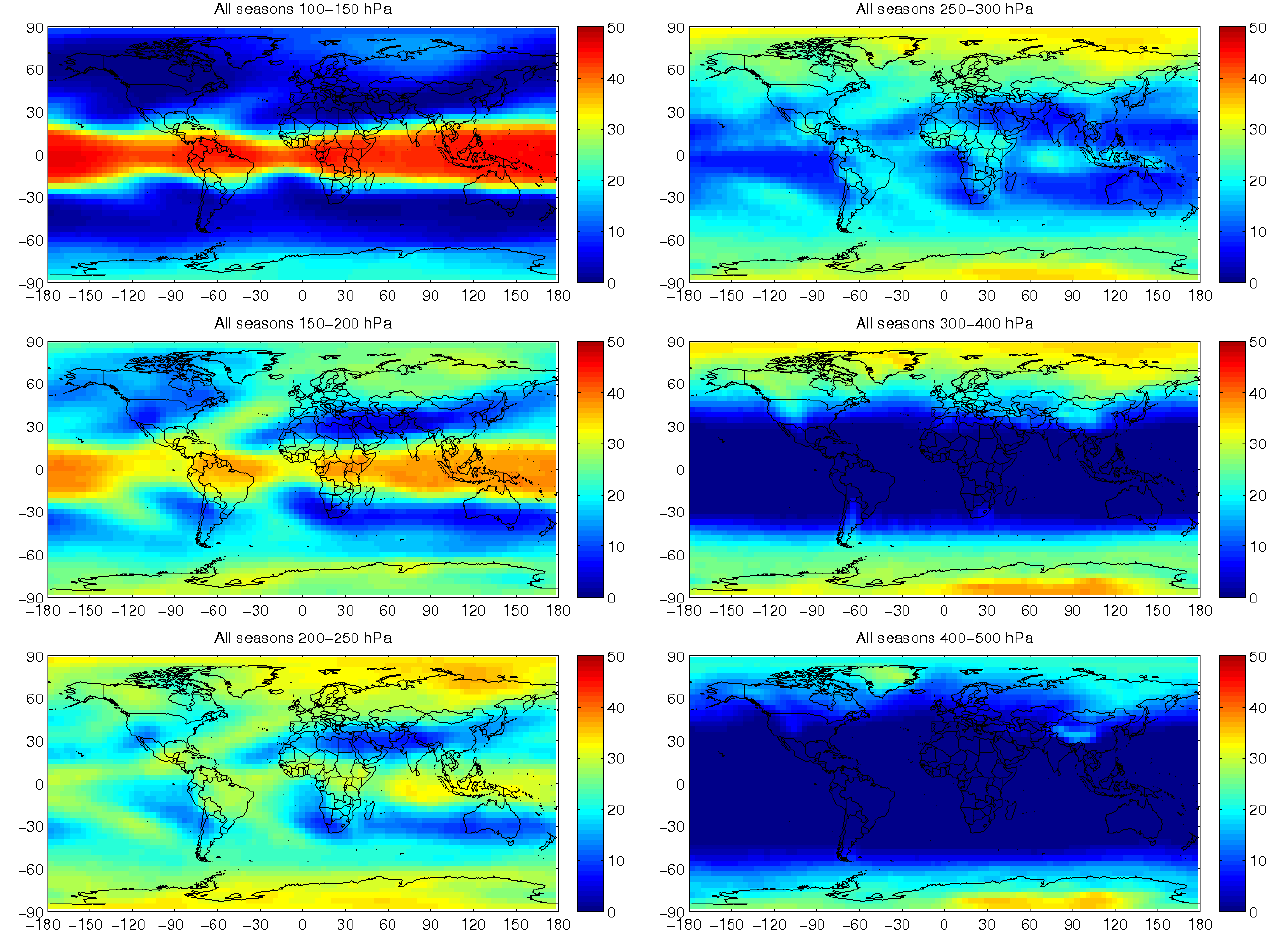
Fig. 19. Ice supersaturation occurrence frequencies (%) from ECHAM in the pressure layers 100–150, 150–200, 200–250, 250–300, 300–400 and 400–500hPa. 5yr of